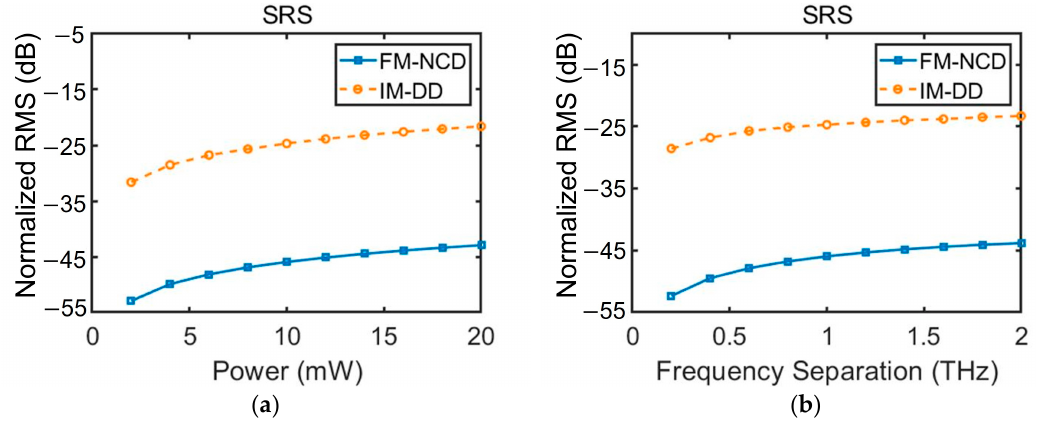
Figure 6. SRS-induced interference (normalized RMS) dependence on ( a ) optical power with a frequency separation of 1 THz, and ( b ) frequency separation with the launched optical power of an interfering signal of 10 mW. The probe signal power launched into the fiber is maintained at 1 mW.